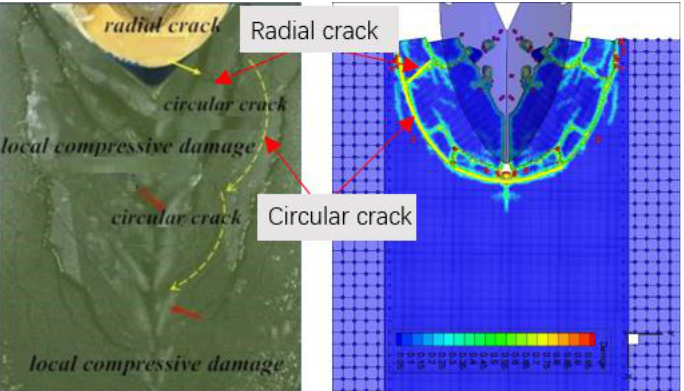
Figure 12. Picture of level ice failure in the model test of Xuelong model at Tianjin University.